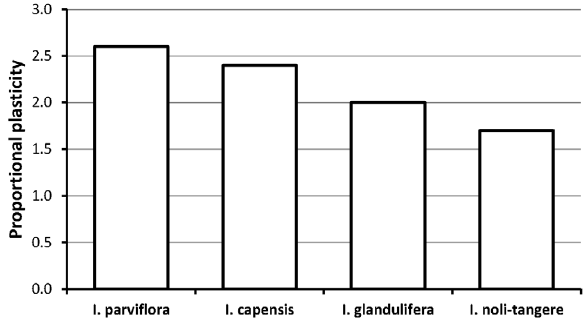
Figure 2. Species plasticity expressed as average proportional difference between the largest and the smallest value of stem height, shoot and relative leaf biomass in the first experiment for both levels of shade and soil moisture. Relative biomass was obtained from a model in which the total shoot biomass was fitted as a